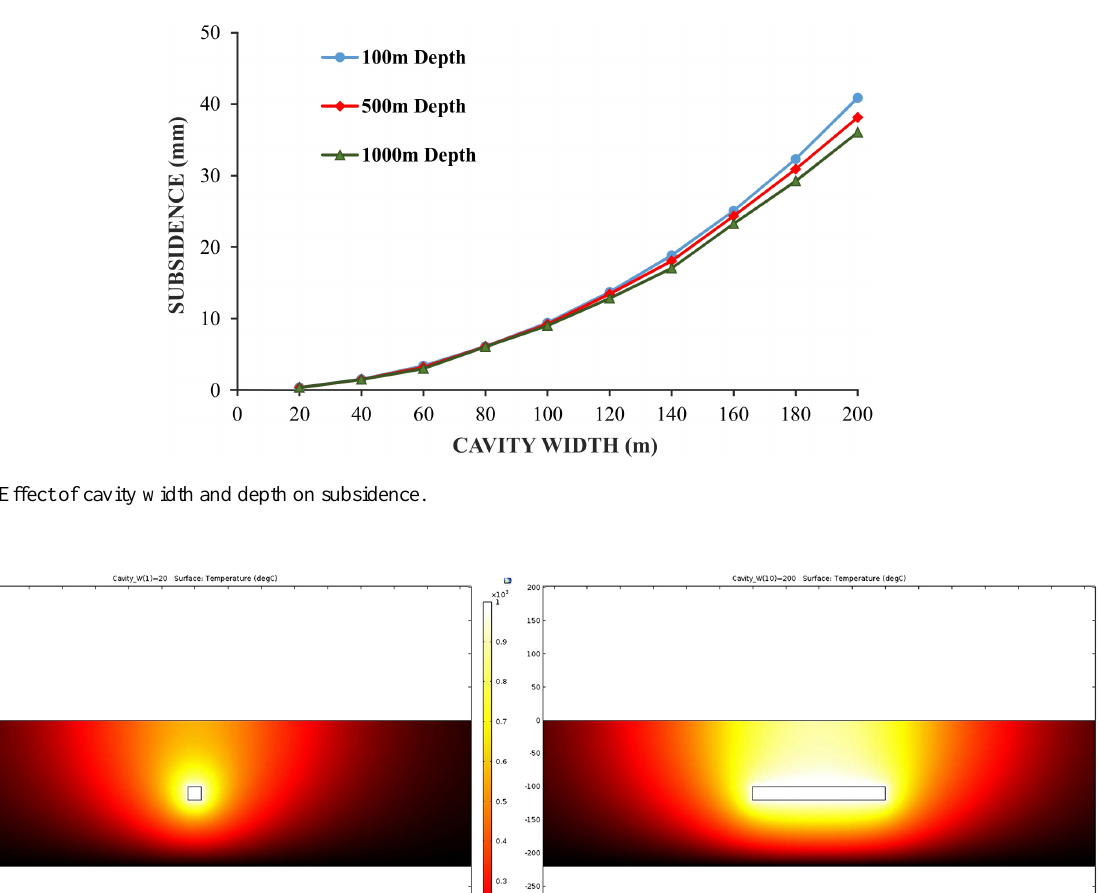
Proc. IAHS, 372, 455–462, 2015